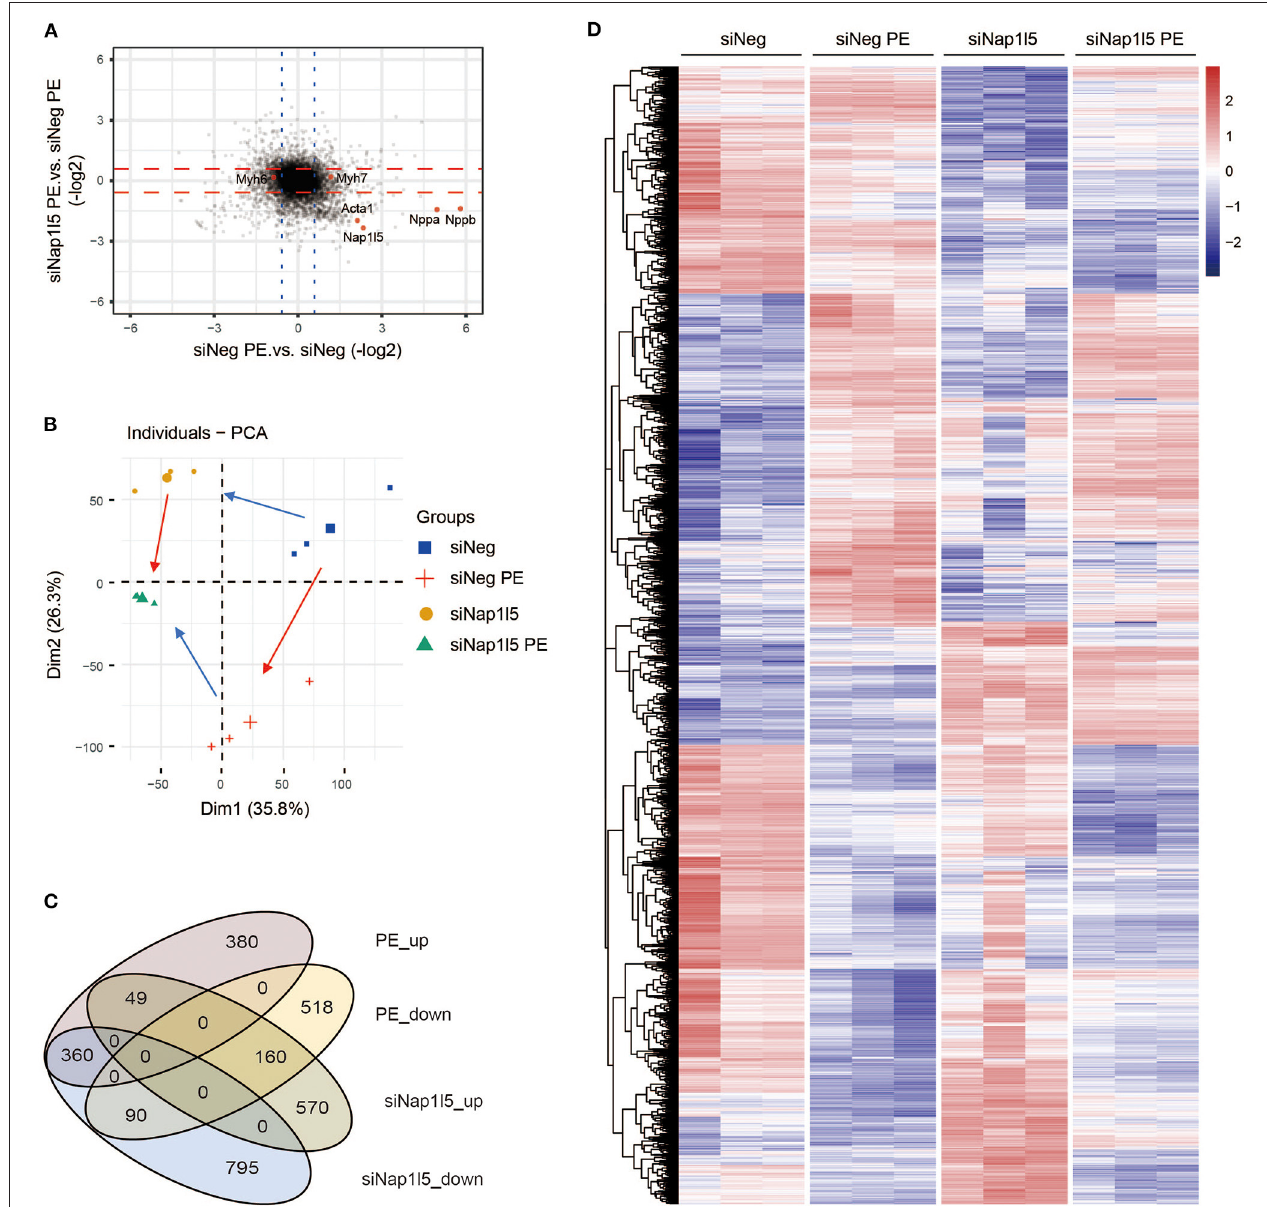
FIGURE 3 | NAP1L5 knockdown reverses hypertrophic transcriptome reprogramming. (A) Two-dimensional plotting showing the impact of Nap1l5 knockdown and PE treatment on gene expression. Red and blue lines indicate the threshold of 1.5-fold changes. The expressions of Nap1l5, Nppa, Nppb, Acta1, Myh6, and Myh7 are highlighted. (B) Principal component analysis (PCA) showing the distribution of gene profiles from NRVMs transfected with siNeg or siNap1l5, with and without PE treatment. Red arrows indicate the changes from Control to PE; blue arrows indicate changes from siNeg to siNap1l5. (C) Venn diagram showing the relationship among up- and down-regulated genes by PE treatment or Nap1l5 knockdown. (D) Heatmap of the altered genes by either PE treatment or Nap1l5